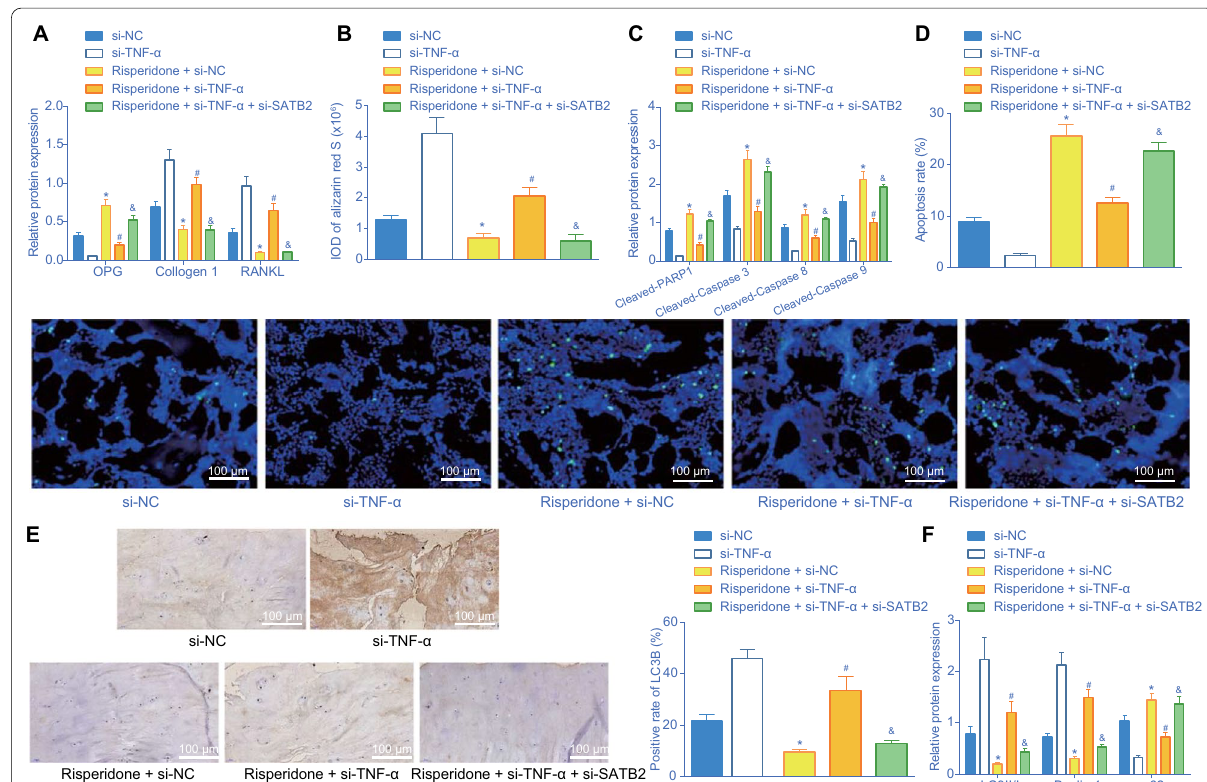
Fig. 8 Risperidone represses differentiation and autophagy while enhancing apoptosis via the TNF-α/SATB2 axis in vivo. A, Western blot analysis of differentiation-related proteins (OPG, collagen I and RANKL) expression in femur tissues of mice. The band intensity was assessed. B, statistical results of alizarin red S staining in femur tissues of mice. C, Western blot analysis of apoptosis-related proteins (cleaved PARP1, cleaved caspase-3, cleaved caspase-8 and cleaved caspase-9) in femur tissues of mice. The protein band was assessed. D, apoptosis rate in femur tissues in mice assessed by TUNEL staining. E, representative images of femur tissues in mice stained by immunohistochemistry and statistical results of LC3B positive rate. F, Western blot analysis of autophagy-related proteins (LC3 II/I, Beclin1, and p62) in femur tissues of mice. The band intensity was quantified and analyzed. * p < 0.05, compared with mice introduced with lentivirus expressing si-NC. # p < 0.05, compared with mice introduced with Risperidone lentivirus expressing si-NC. & p < 0.05, compared with mice introduced with Risperidone lentivirus expressing si-TNF-α. The + + experiments are repeated 3 times n =